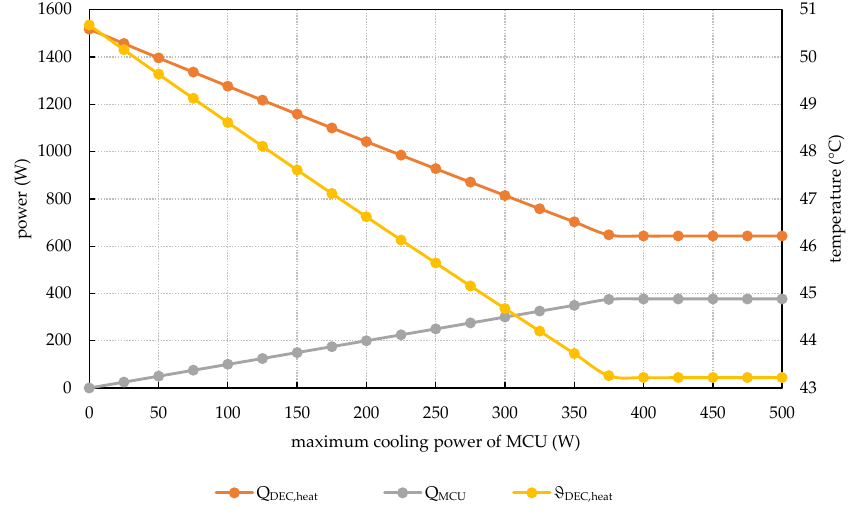
Figure 10. Influence of MCU power on DEC heating power and heat